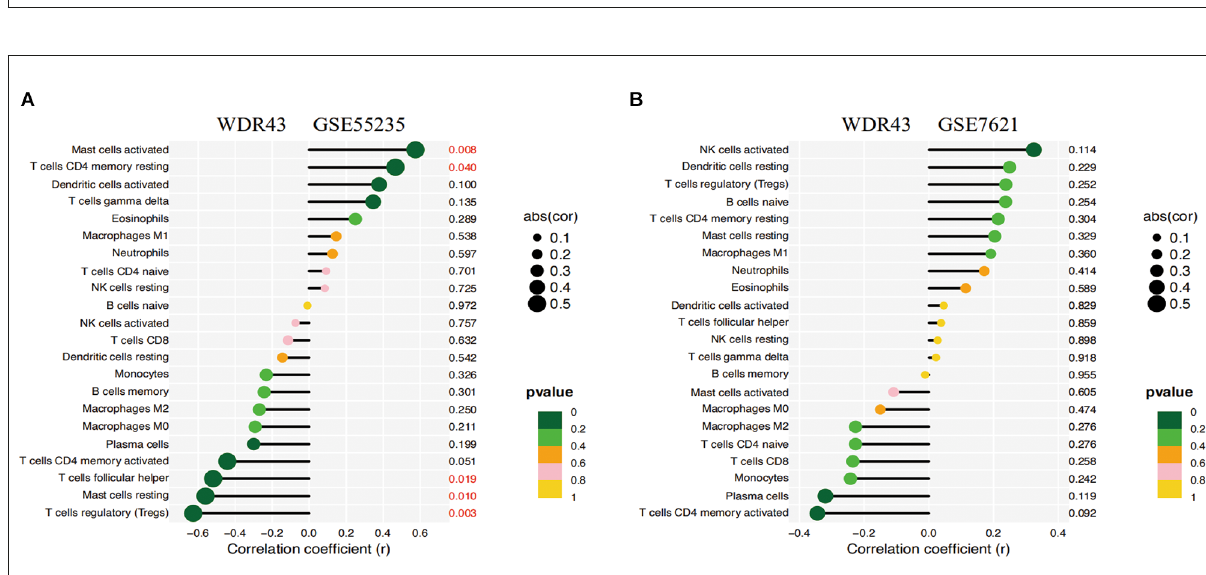
FIGURE10 (A,B) Correlation analysis of WDR43 and immune infiltrating cells, the size of the circle determined the intensity of the correlation’s absolute value. P values less than 0.05 was highlighted in red, with smaller and smaller P values progressing from yellow to dark green.